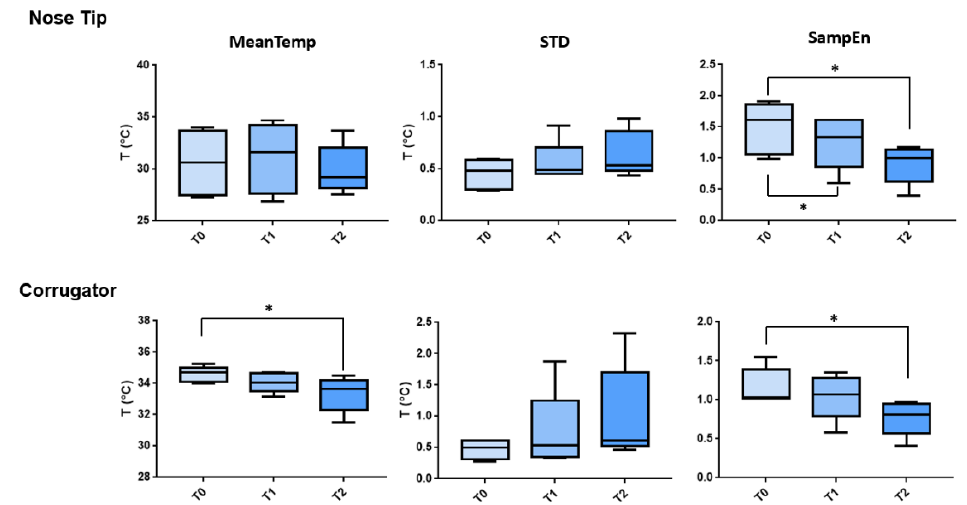
Figure 3. Boxplot associated with the thermal features evaluated for the nose tip and corrugator across the experimental sessions (i.e., T0, T1, and T2). The significant comparisons are highlighted in the figure with the asterisks (*). Table 2. Multiple comparisons (paired t -test) related to the RM-ANOVA. In the table, only significant comparisons are shown.